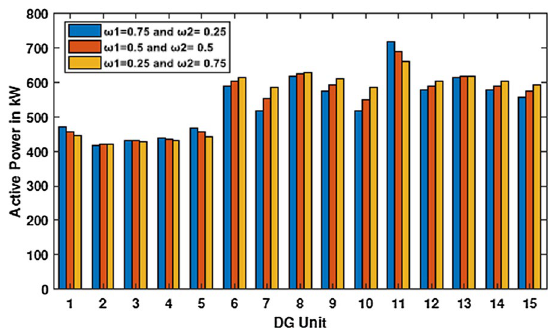
Fig. 3 Impact of ω 1 and ω 2 on the DG unit’s generation